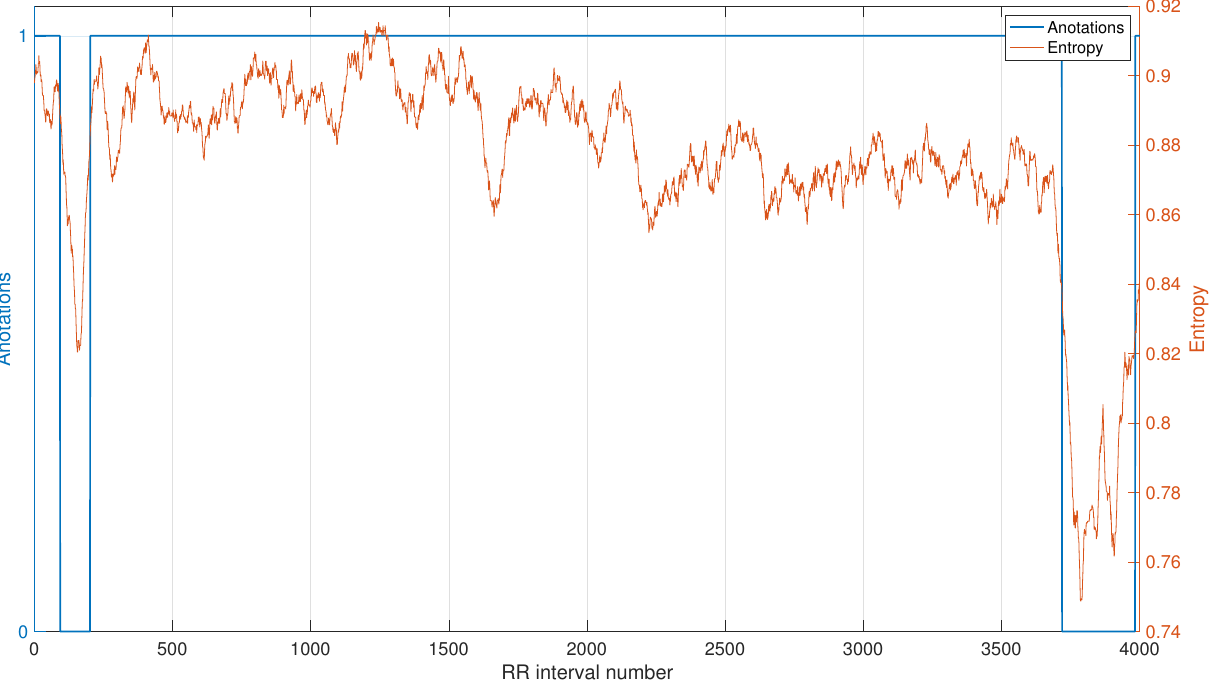
Figure 2. Illustration of AF detection algorithm, showing annotations and Shannon